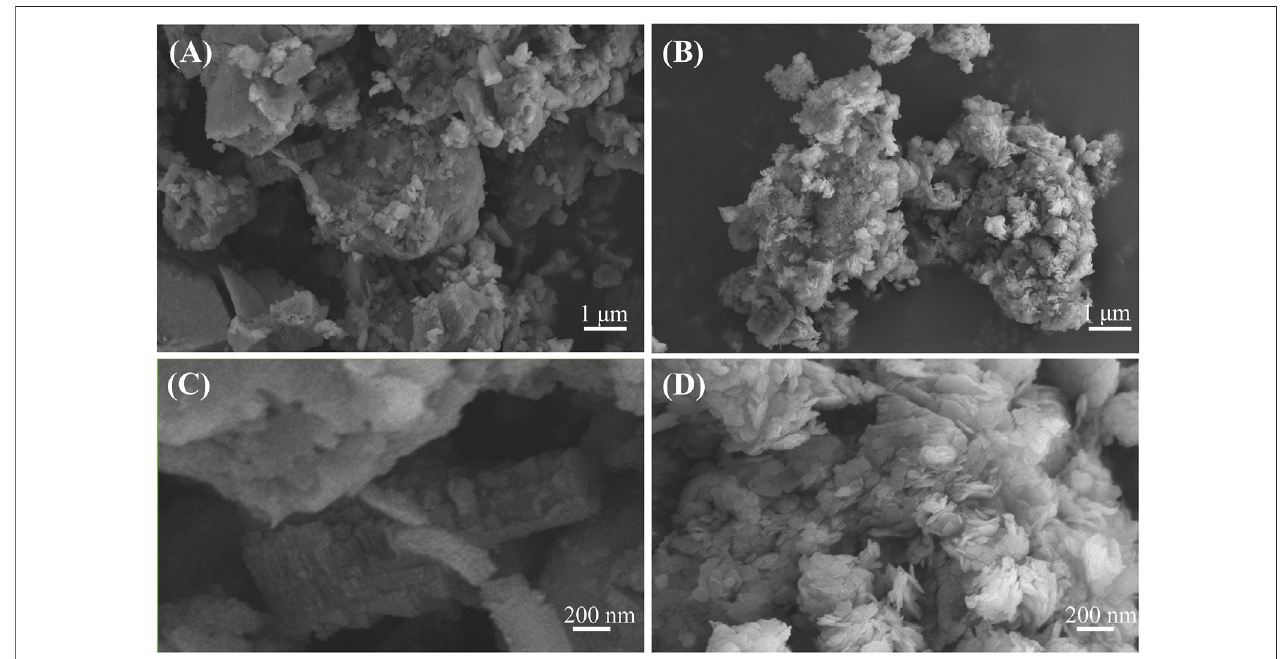
FIGURE 8 | SEM images of the (A,C) NCA-3 and (B,D) CA-4 samples.